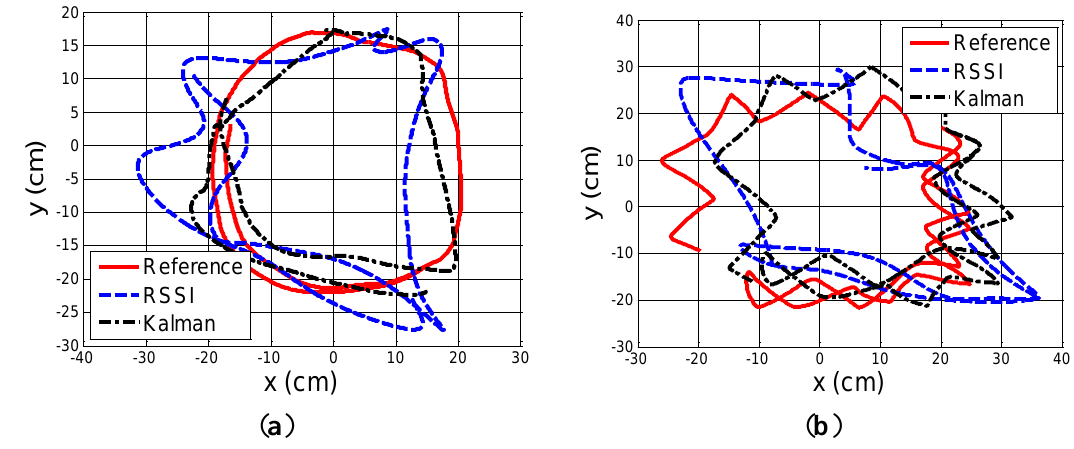
Figure 10. Location estimation of the RSSI, Inertial Sensor (INS), and the Kalman filter, compared to the reference (Polaris) system. Figure ( a ), and Figure ( b ) describes circular, and zig-zag motion,